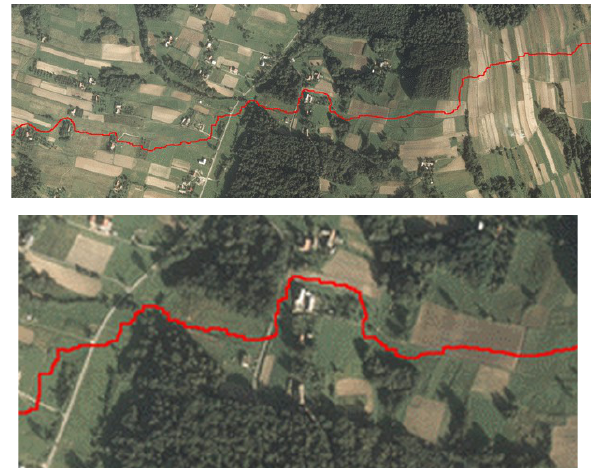
Figure 9. An example of routing the seamlines through a foothill area (enlargement in the bottom row)